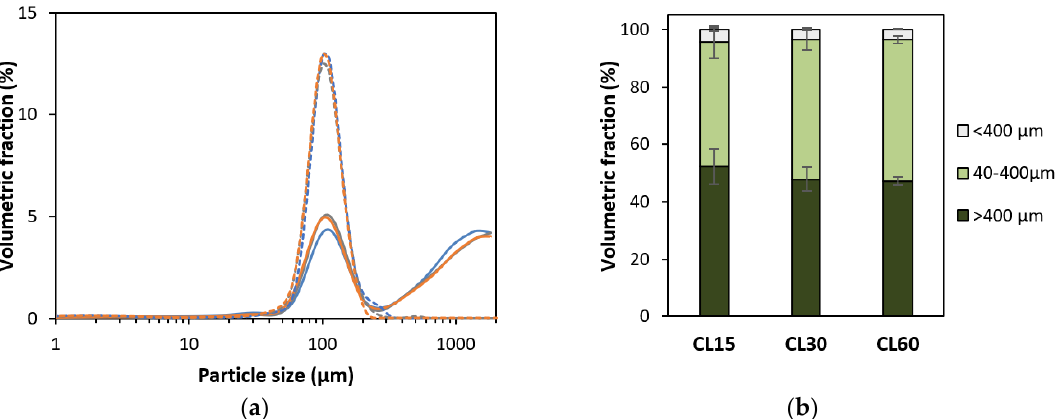
Figure 2. ( a ) Particle size distributions of cooked lentils (CL) and isolated cotyledon cells (ICC) cooked for 15 ( − ), 30 ( − ), or 60 ( − ) minutes. For each sample type, an averaged curve is shown. Full lines represent mechanically disintegrated cooked lentils, and dotted lines represent isolated cotyledon cells. ( b ) Volumetric distribution of CL with a cooking time of 15, 30, or 60 min in different size fractions calculated from duplicate PSD measurements.